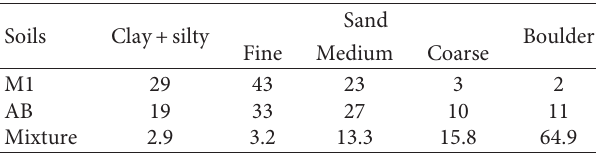
Table 2: Summary of the granulometric composition (%) of the study materials.